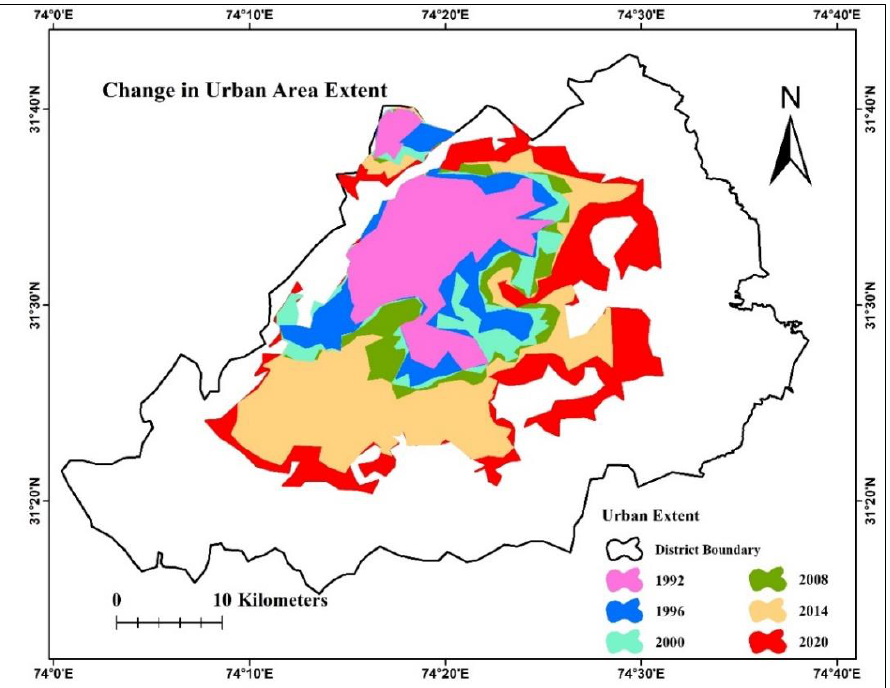
Figure 4. Change in urban built-up area and its expansion from 1992 – 2000 and from 2008 – 2020. Table 2. Temporal LULC changes (in percent) for each measured year from the previous one from period 1992 to 2020 with overall change.